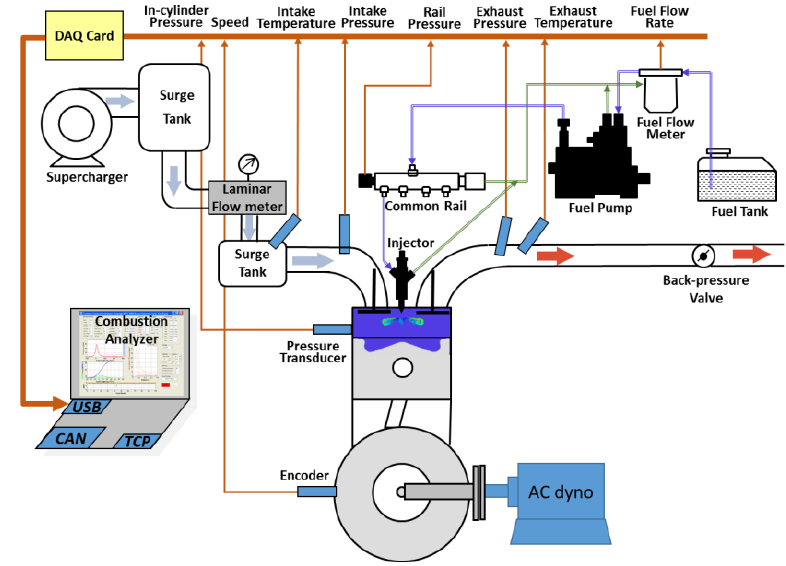
Figure 2. Bench test system for the single cylinder diesel engine. Table 2. Boosted diesel engine test system.